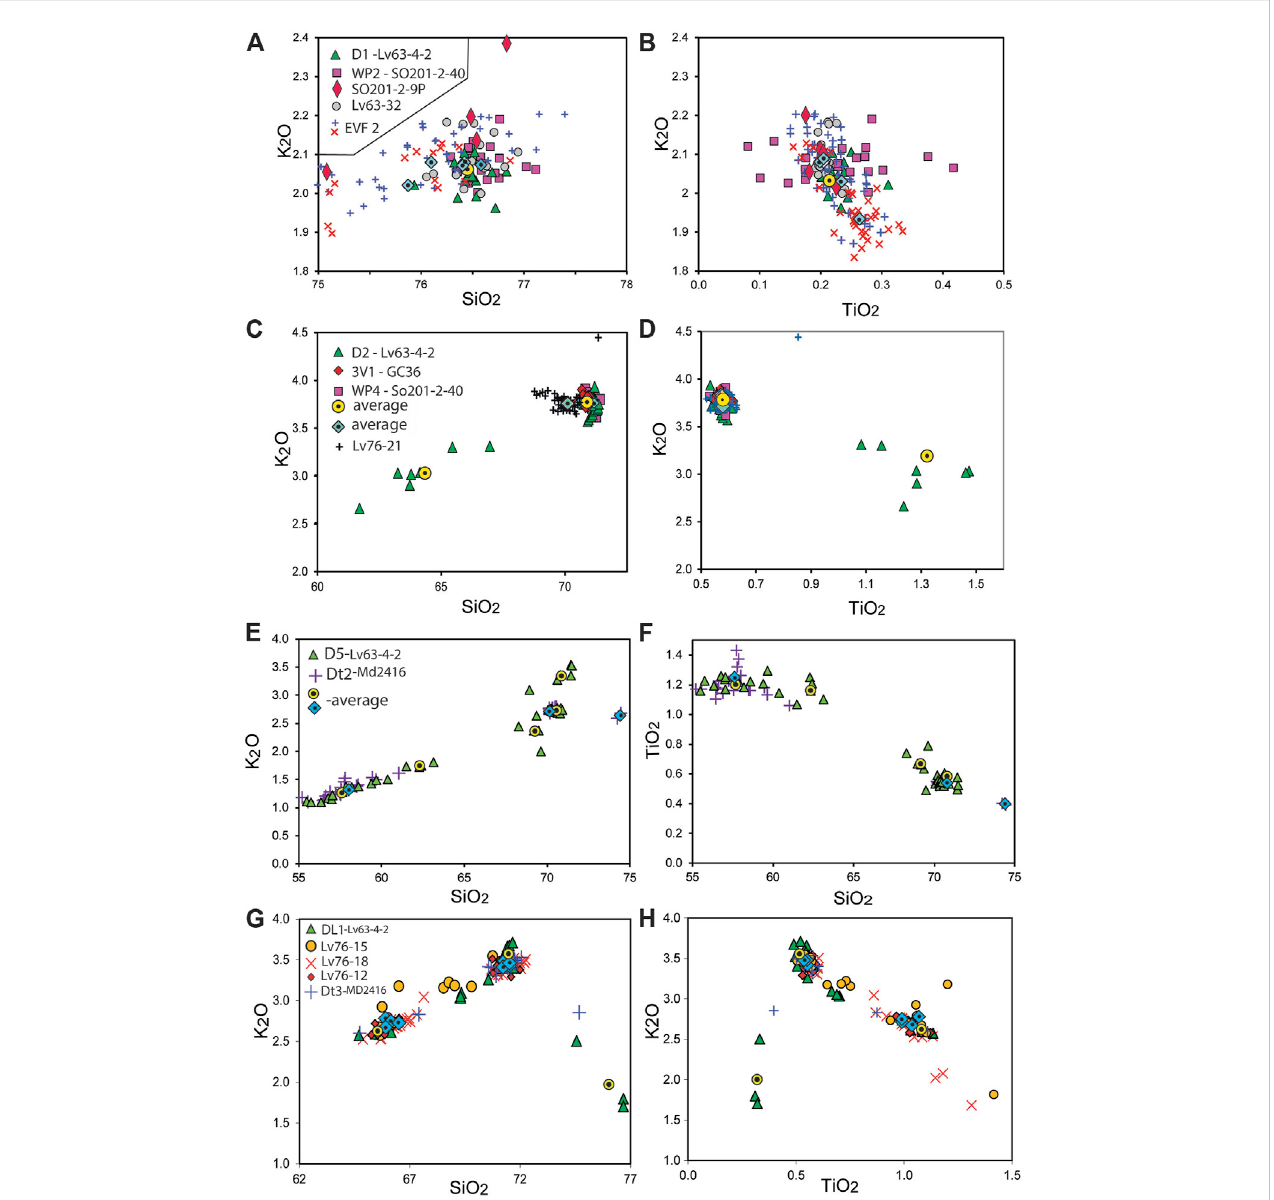
FIGURE 6 Comparison ofthevolcanicglasscompositionsfromdifferenttephra(SiO 2 -K 2 OandTiO 2 -K 2 Odiagrams). (A,B) ComparisonofglassfromtephraD1with glasses from tephra WP2 (So201-2-40, So201-2-9P, Lv63-32, and Lv76-21) and from the proximal tephra EVF2 (Kamchatka) (Ponomareva et al., 2021); (C,D) Comparison of glass from tephra D2 with glass from distal tephra WP4, 3V1 and Lv76-21 (Gorely volcano) (Derkachev et al., 2020); (E,F) Comparison of glass compositions from tephra D5 with tephra Dt2 (MD2416); (G,H) Comparison of glass compositions from tephra DL1 with tephra Dt3 (MD2416) and st. Lv76-12, Lv76-15, and Lv76-18. The reference data for the samples are provided in Supplementary Table